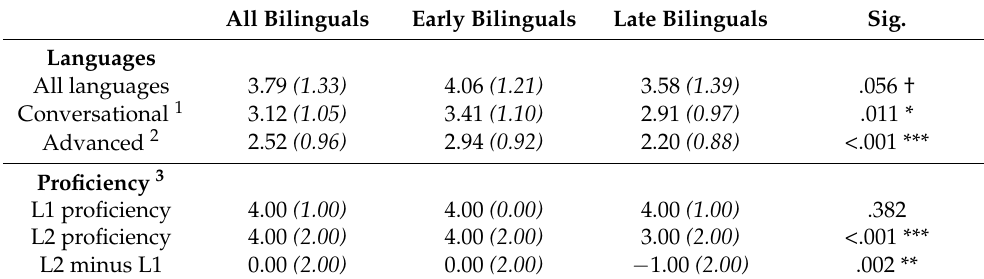
Table 2. Group characteristics: mean number of languages (SD) and median proficiency (range) . All Bilinguals Early Bilinguals